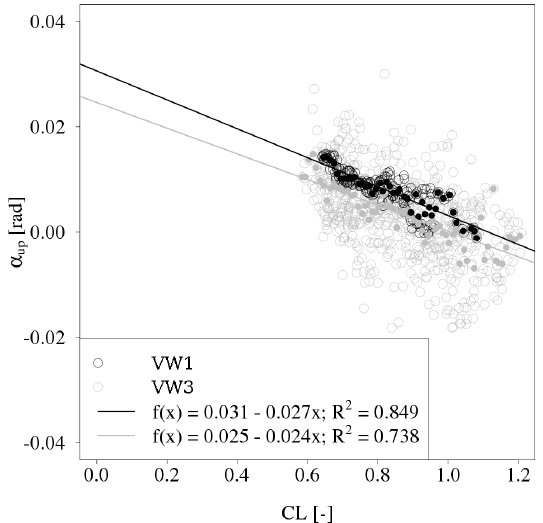
Fig. 9. Upwash attack angle ( α up ) as function of the lift coefficient ( CL ) for two vertical wind specific flight patterns on 25 June 2008 (VW1, VW3). α up is the difference of attack angle as measured by the five hole probe and the inverse reference of the free airstream attack angle (Sect. 4.1 Step G3). Open circles depict the entire 1Hz dataset. Full circles are averages after binning over increments of 0.01 CL .